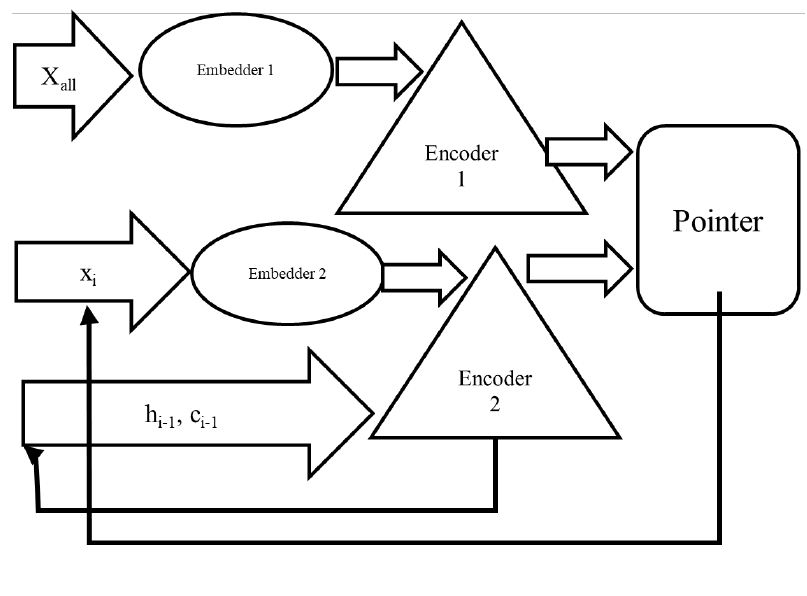
Figure 1. Architecture of the GPN showing how each component interacts and integrates